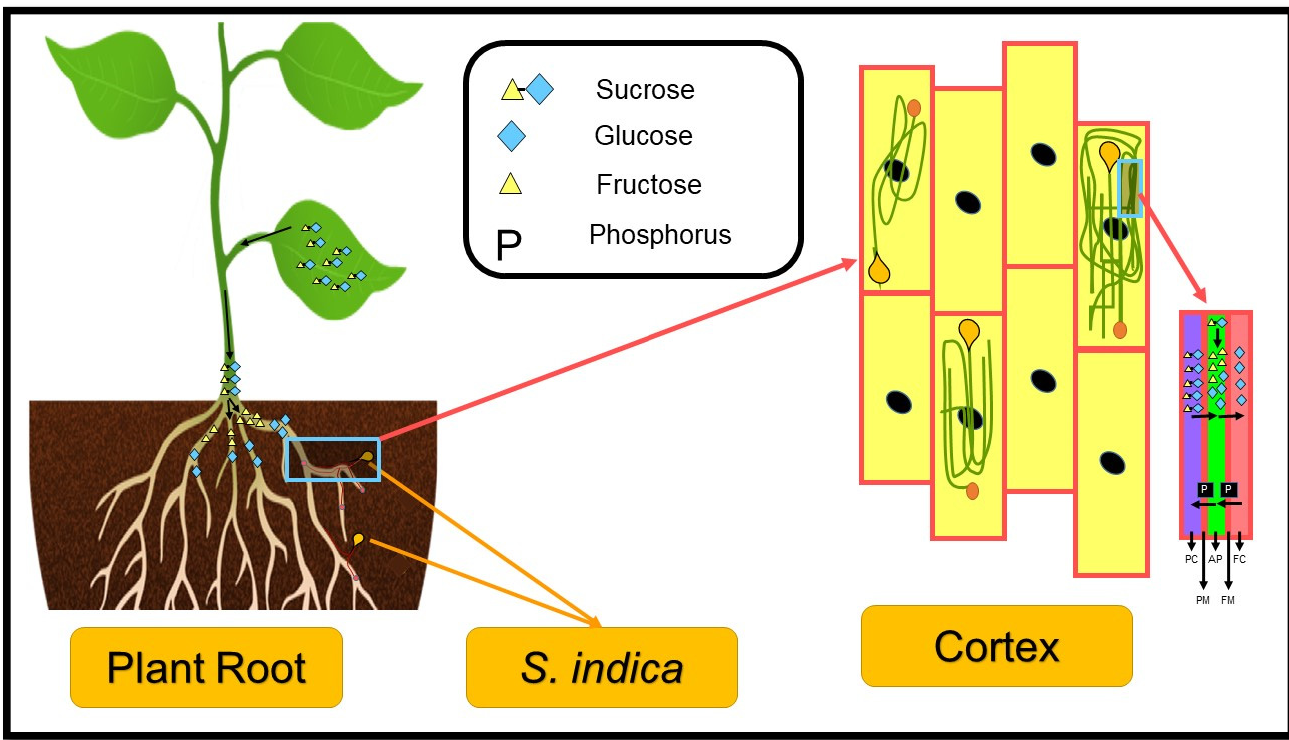
Figure 1. A schematic of S. indica chlamydospores growth in the plant’s root cortex. Nomenclature is as proposed by Opitz et al. [9]. PC—plant cytosol; PM—plant plasma membrane; AP—apoplast; FM—fungal membrane; FC—fungal cytosol.